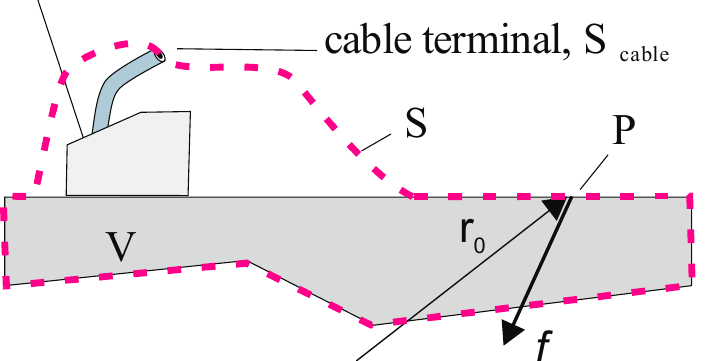
Figure 1. Piezoelectric probe coupled to a solid test specimen; the integration volume V includes the test specimen and the probe and can be of any shape. V has the boundary S indicated by the dashed line. The part of the boundary crossing the electrical coaxial cable is denoted as S cable . The point P at the surface has coordinates r 0 where in state “B” an external point force acts to the surface and the surface velocity is measured in state “A”.